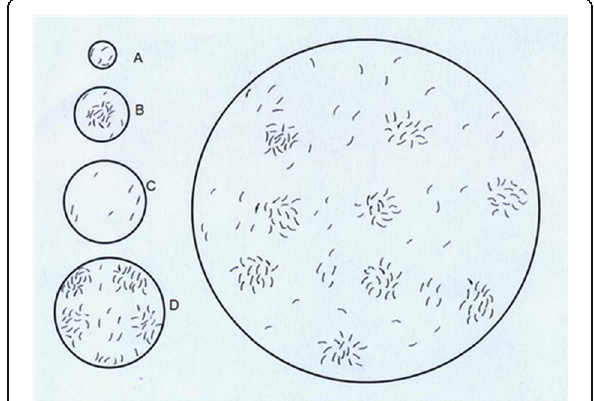
Fig. 1 Four quadrat sizes (A, B, C, D) and a contagious distribution with regularly distributed clumps of entomopathogenic